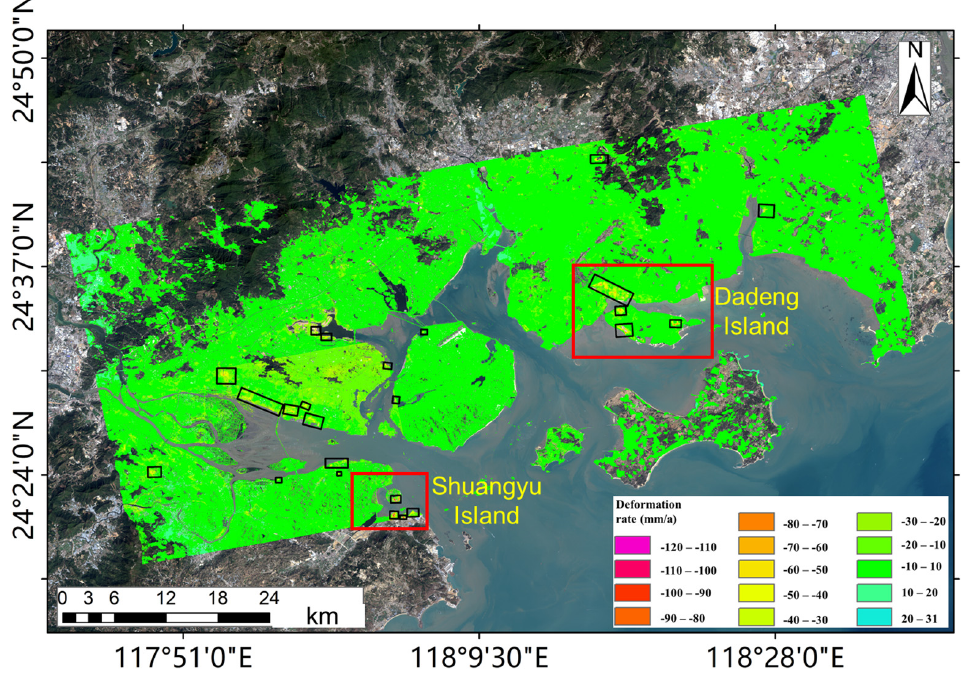
Figure 4. Annual vertical deformation rate map over the whole coastal areas of Xiamen and Zhang- zhou cities, China. Zhangzhou cities,